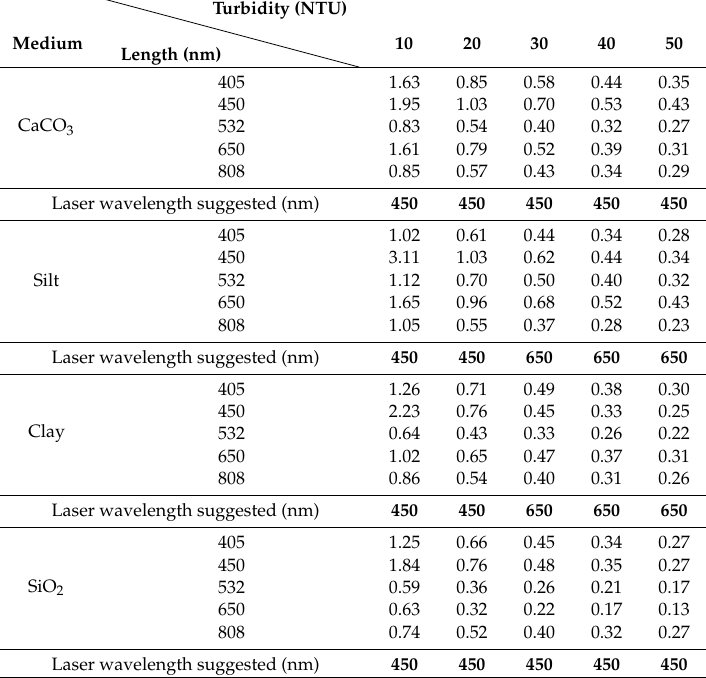
Table 2. Maximum detection range and laser wavelength selection recommendation.